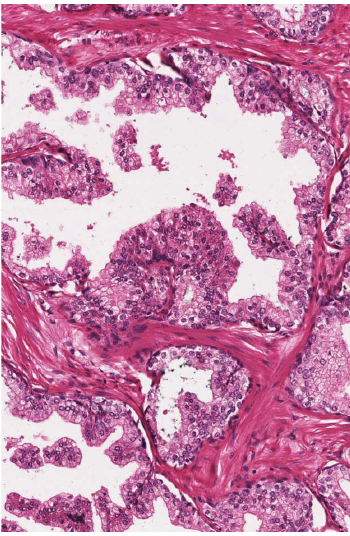
Figure 3: Benign prostatic acini can have undulating, or papillary lumens have lumens that are large and open, usually without bridg- ing across the gland space except in the central zone. Pseudolumen spaces in cancer show various degrees of deviation from normal